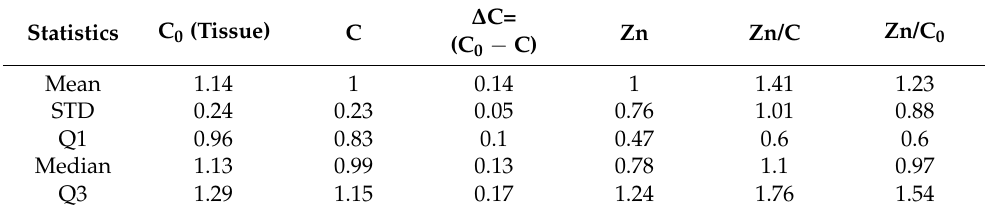
Table 1. Population parameters